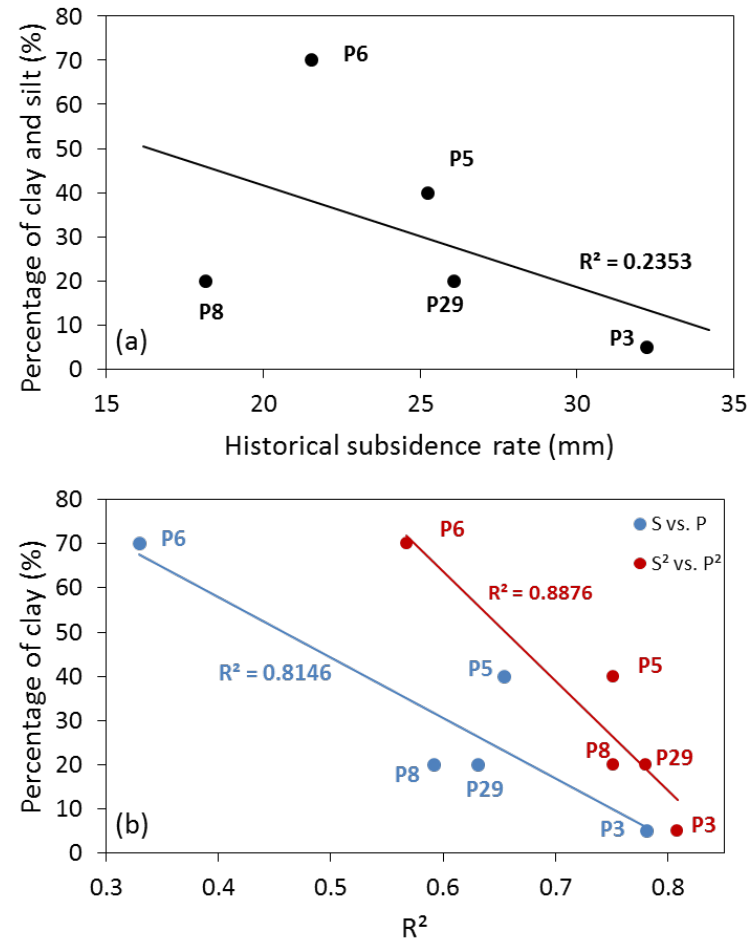
Figure 8. Relationship between the percentage of clay and silt and the historical subsidence rate ( a ) and the correlation coefficients obtained for the two best linear regression models (S = a × P + b; S² = a × P² + b) ( b ).